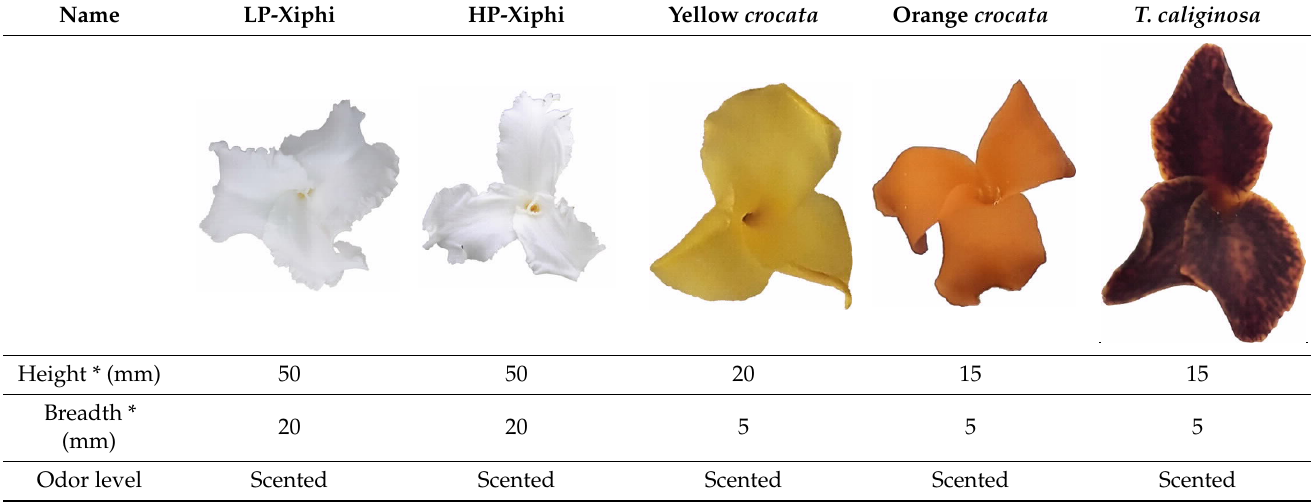
Table 2. Identification of volatile compounds from floral emissions of T. xiphioides , T. crocata , and T. caliginosa